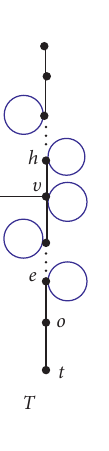
Figure 3: The trees T and T